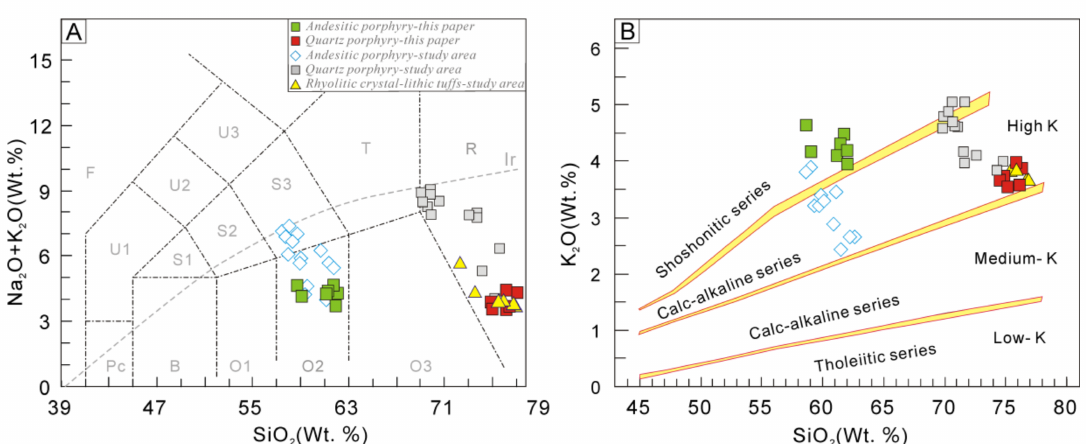
Figure 5. ( A ) SiO 2 versus (Na 2 O + K 2 O) diagram [66]. ( B ) Si 2 O versus K 2 O diagram [67]. B: basalt; O1: basaltic andesite; O2: andesite; O3: dacite; R: rhyolite; T: trachyte or trachydacite; S1: trachybasalt; S2: basaltic trachyandesite; S3: trachyandesite; Pc: picrobasalt; U1: basanite or tephrite; U2: phonotephrite; U3: tephriphonolite; F: foidite. Other data are quoted from the literature